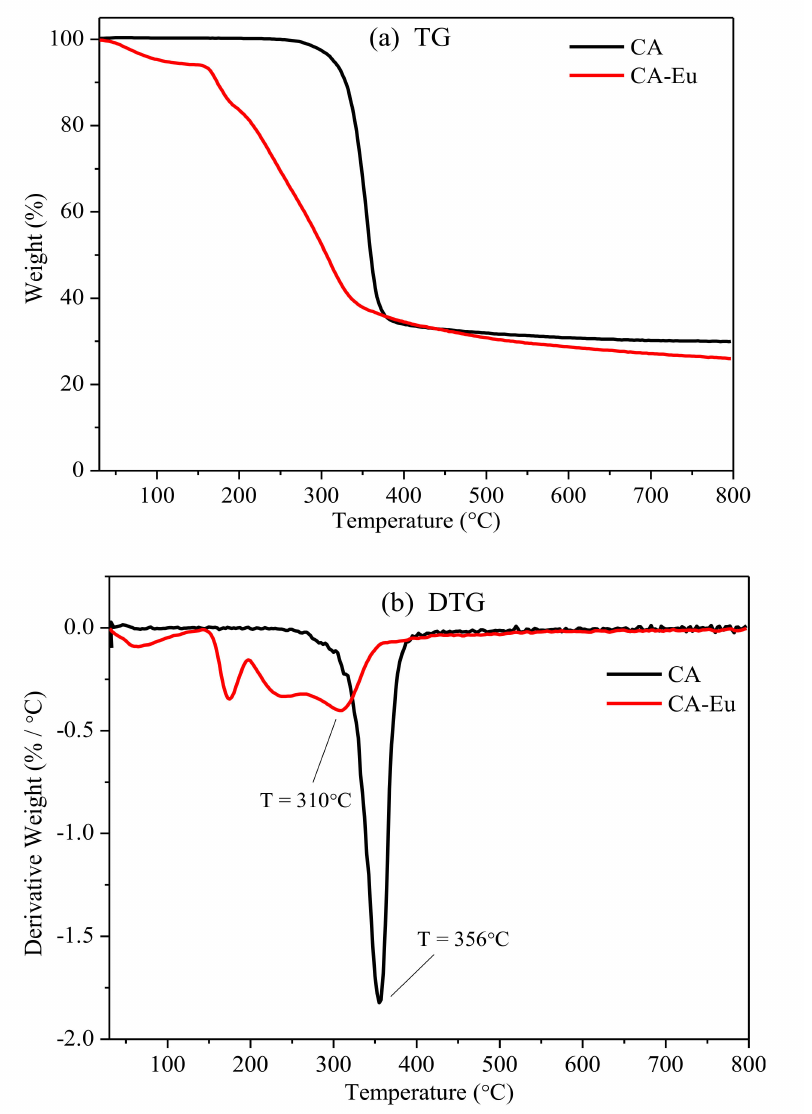
Figure 9. Thermogravimetric (TG) and derivative thermogravimetric (DTG) curves of CA and CA-Eu films. ( a ) TG, ( b )